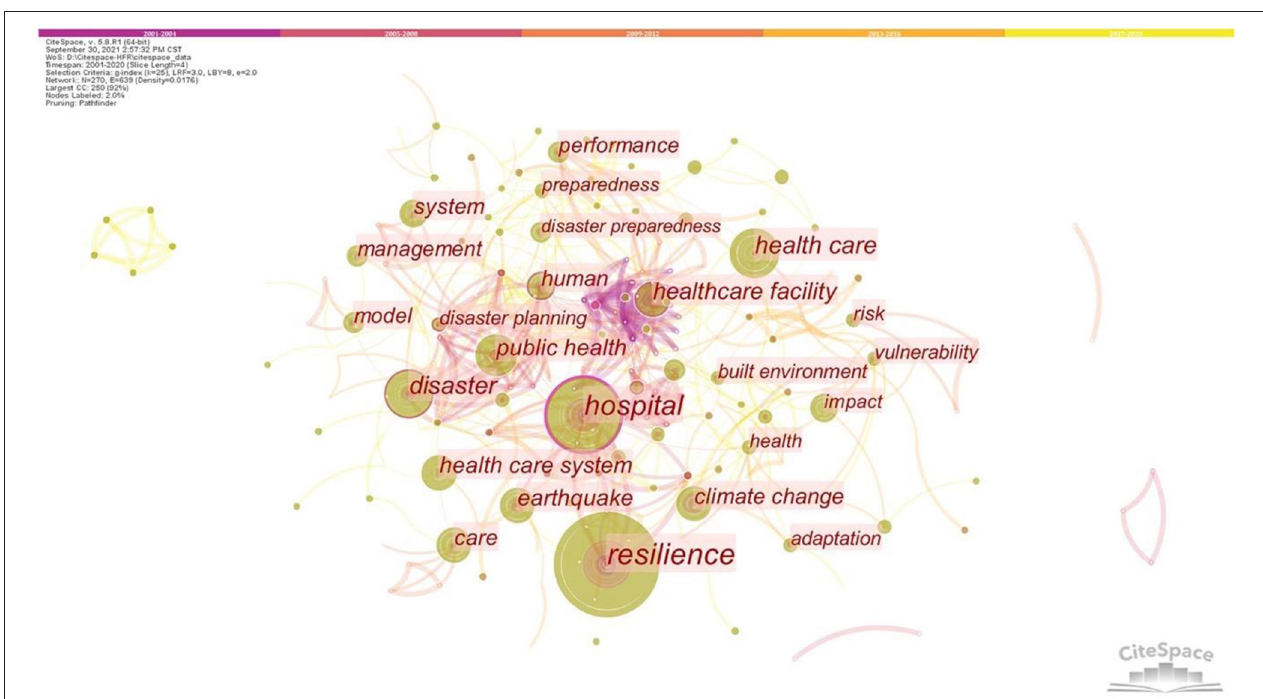
FIGURE 5 | The co-occurrence network of